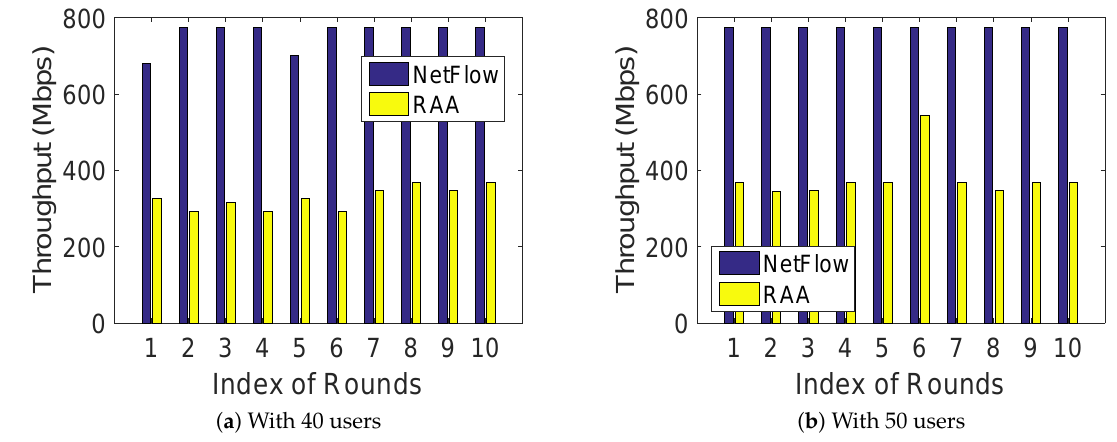
Figure 3. Throughput comparison for 10 rounds.